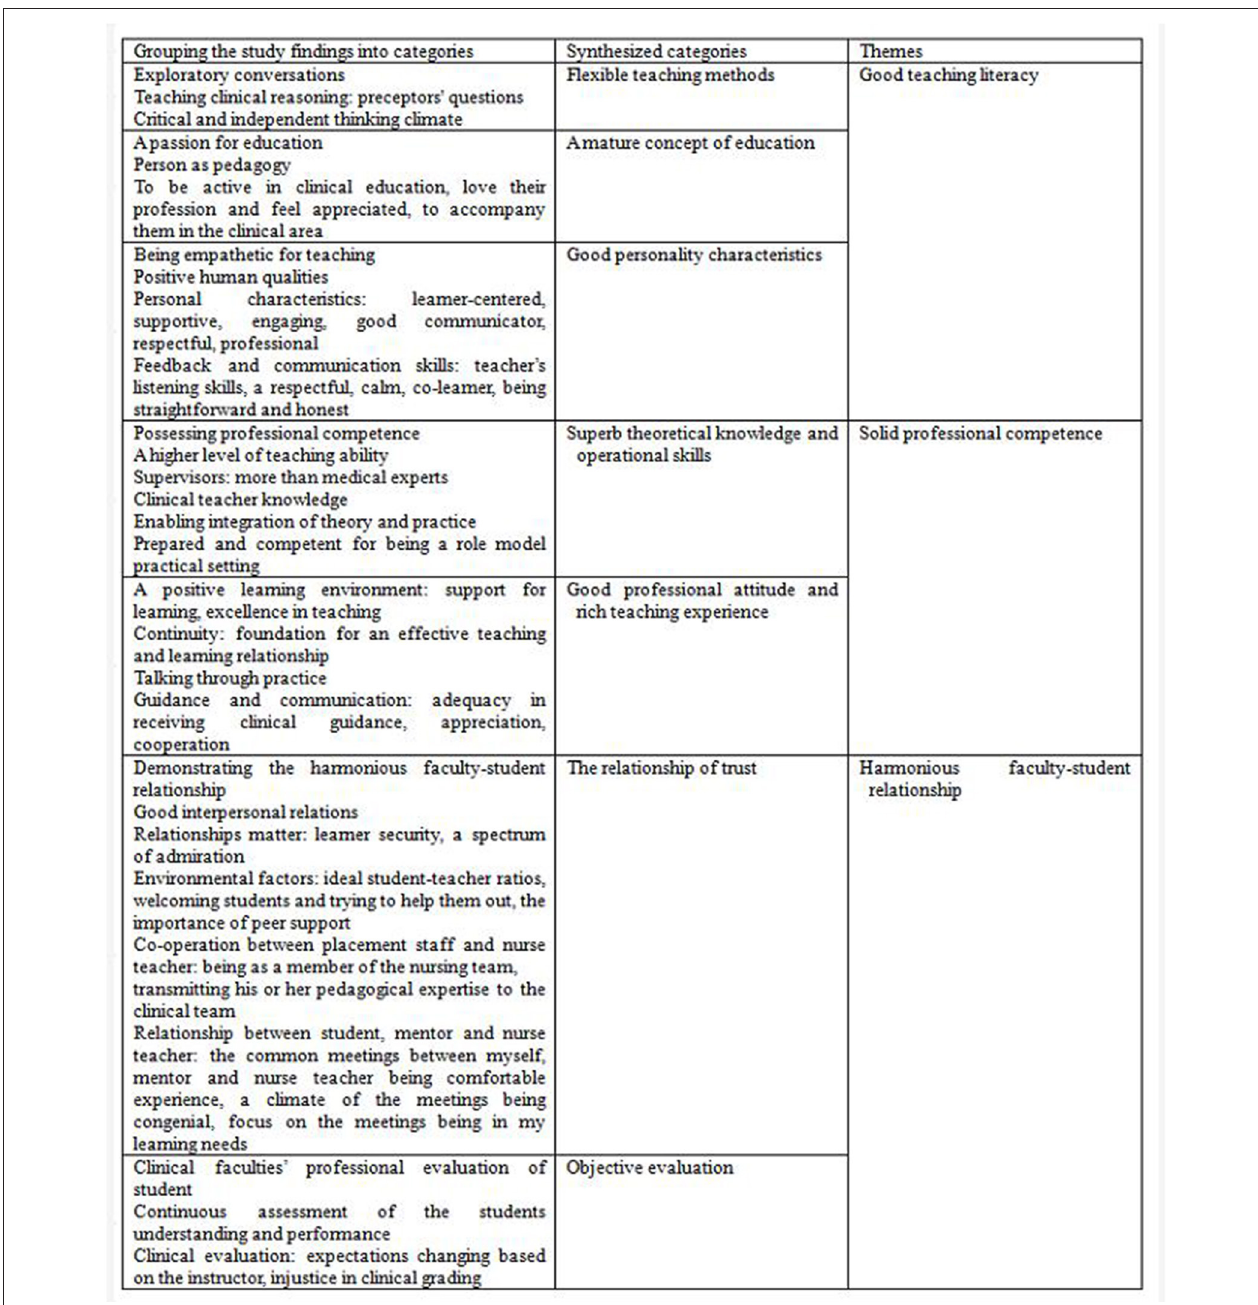
FIGURE 3 | The meta-aggregative approach from grouping the study findings into categories and synthesizing the categories into themes.